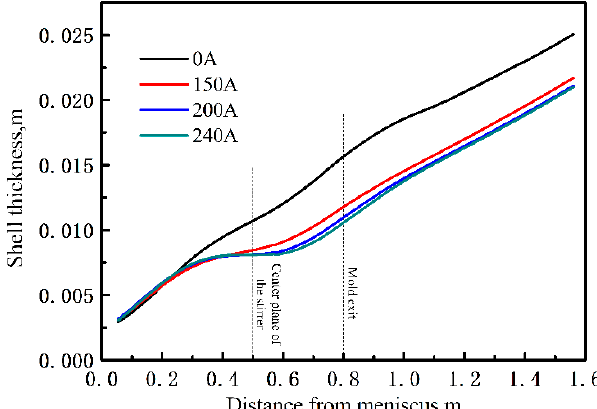
Figure 9. The growth of shell thickness along the casting direction.